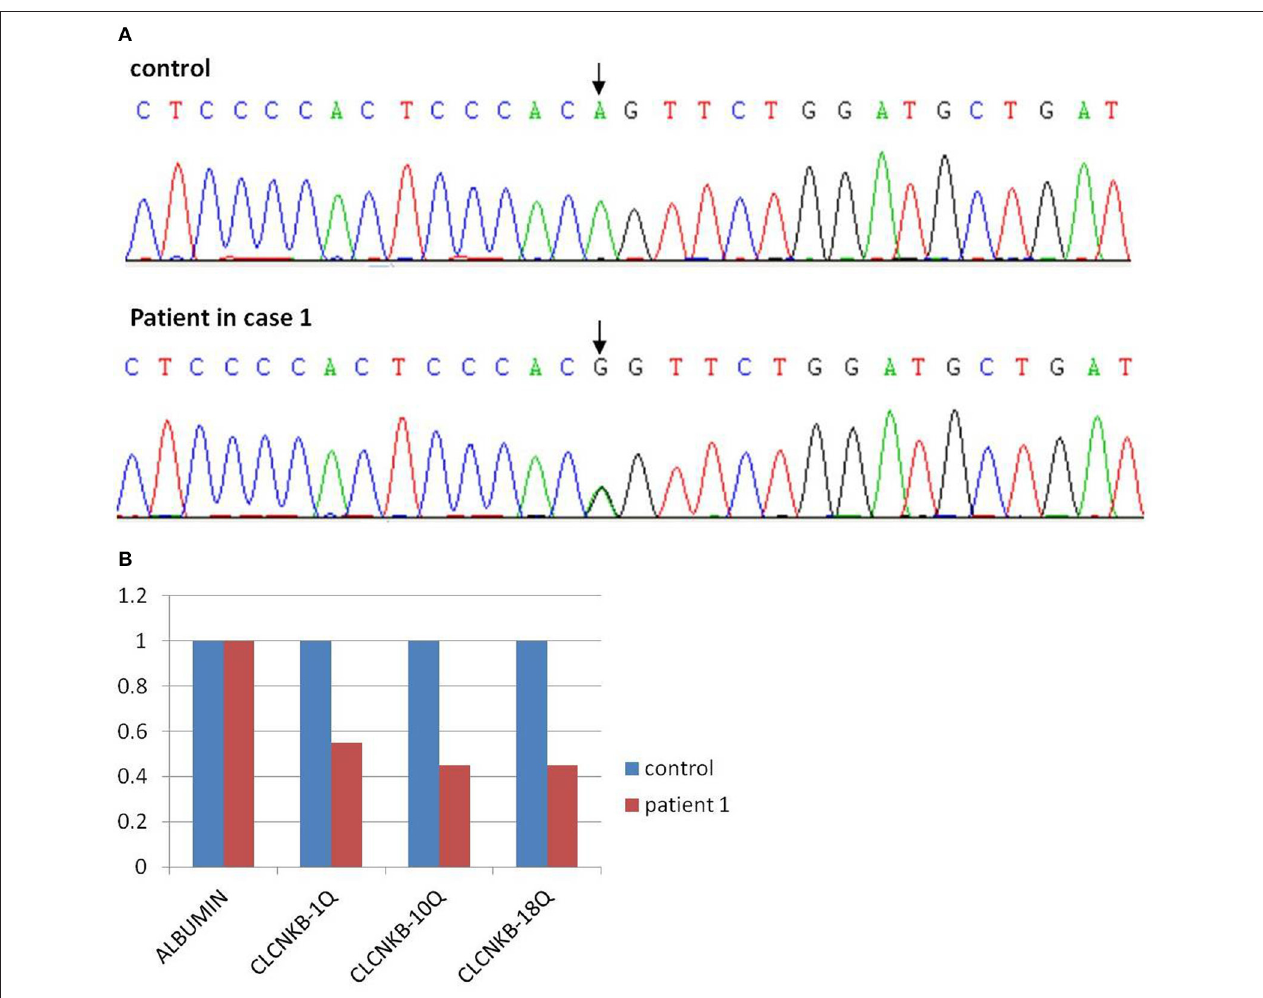
FIGURE 2 | Mutation analysis of patient 1 showed a point mutation of CLCNKB (A) and a loss of exons 1–18 (B) .